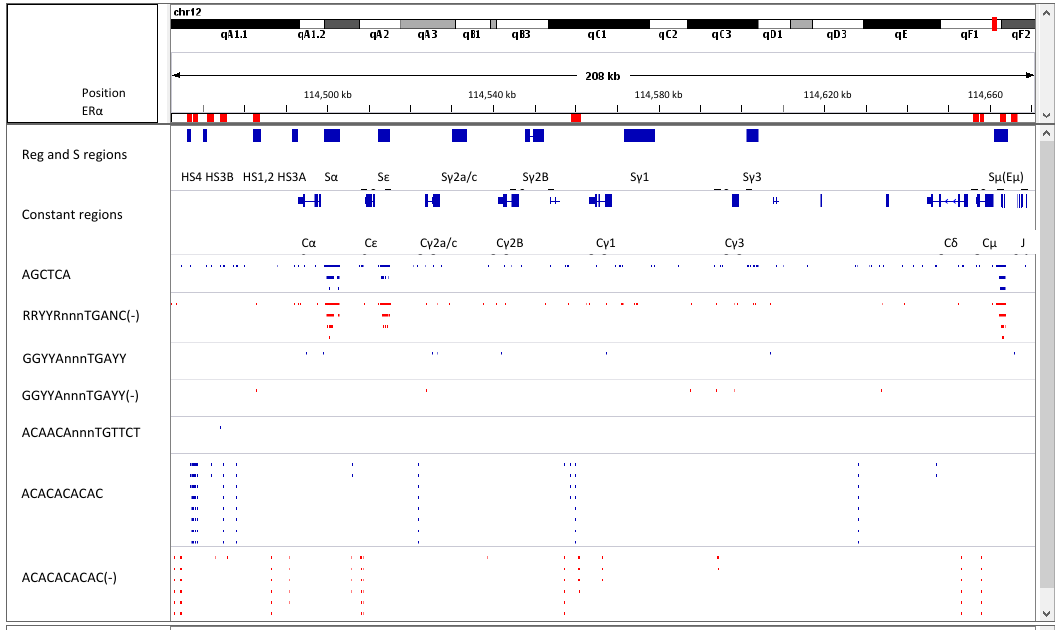
Figure 1. Potential retinoic acid response elements (RARE), estrogen response elements (ERE), and androgen response elements (ARE), ER α binding locations, and CA-rich sequences in the immunoglobulin heavy chain locus. A map of the immunoglobulin heavy chain locus is shown using IGV software. Regulatory regions, S regions, and constant regions are indicated. Note that E µ is located just upstream of S µ . The Findseq function was used to identify positions of select sequences. A negative sign indicates the reverse complement. Sequences included AGCTCA (a potential RARE, note one mismatch with the consensus), RRYYRnnnTGANC (a potential ERE), GGYYAnnnTGAYY (a more stringent, potential ERE), ACAACAnnnTGTTCT (a potential ARE, note one mismatch with the consensus), and ACACACACAC (CA-rich regions). Red rectangles indicate positions of major and minor ER α binding peaks, previously identified by ChIP analyses with purified B cells (from C57BL/6 female mice) after a one-day stimulation [86,93]. Not shown are locations for sequences GGACAnnnTGACC upstream of S γ 2b and TGTTAnnnTGACC near